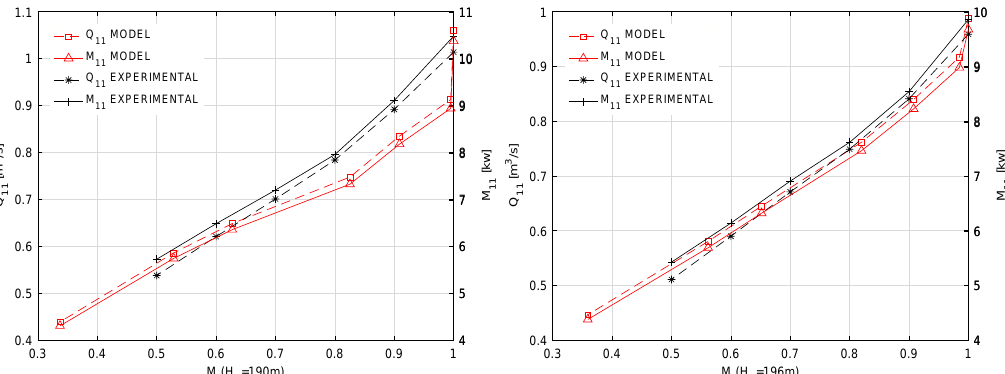
Figure 11. Comparisons of numerical and experimental data, at different heads and power factors, in turbine conditions.